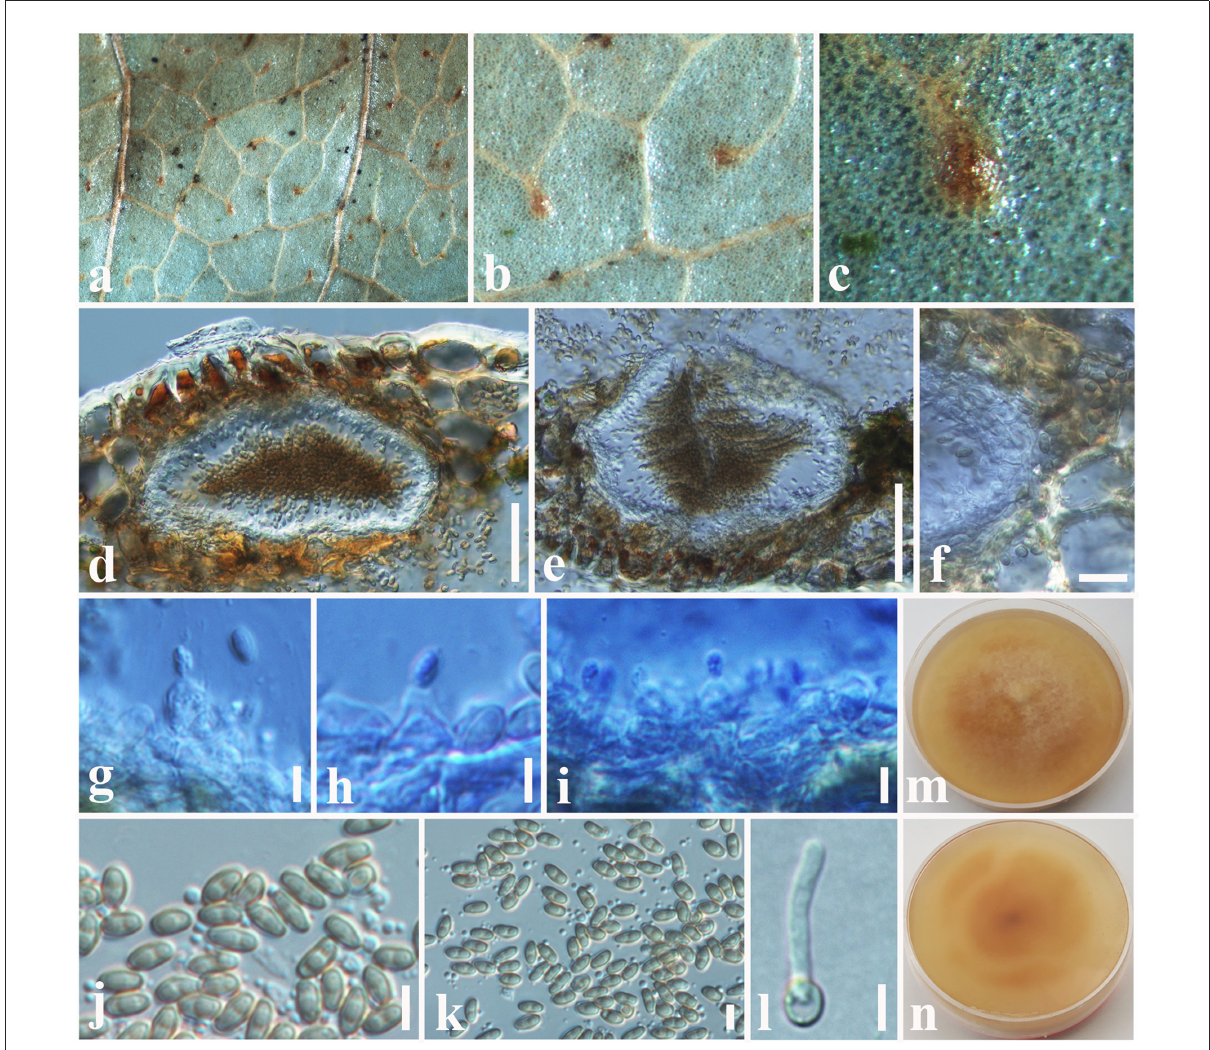
FIGURE7 Paraconiothyrium fuckelii (MFLU 18-2605, new host record): (a,b) Conidiomata on a dead leaf of Dimocarpus longan . (c) Close-up of conidioma. (d,e) Sections through conidiomata. (f) Conidiomatal wall. (g–i) Conidiogenous cells and developing conidia. (j,k) Conidia. (l) Germinating conidium. (m) Upper side of the culture. (n) Lower side of the culture. Scale bars: (d,e) = 100 µ m, (f) = 10 µ m, (g–l) = 3 µ m.